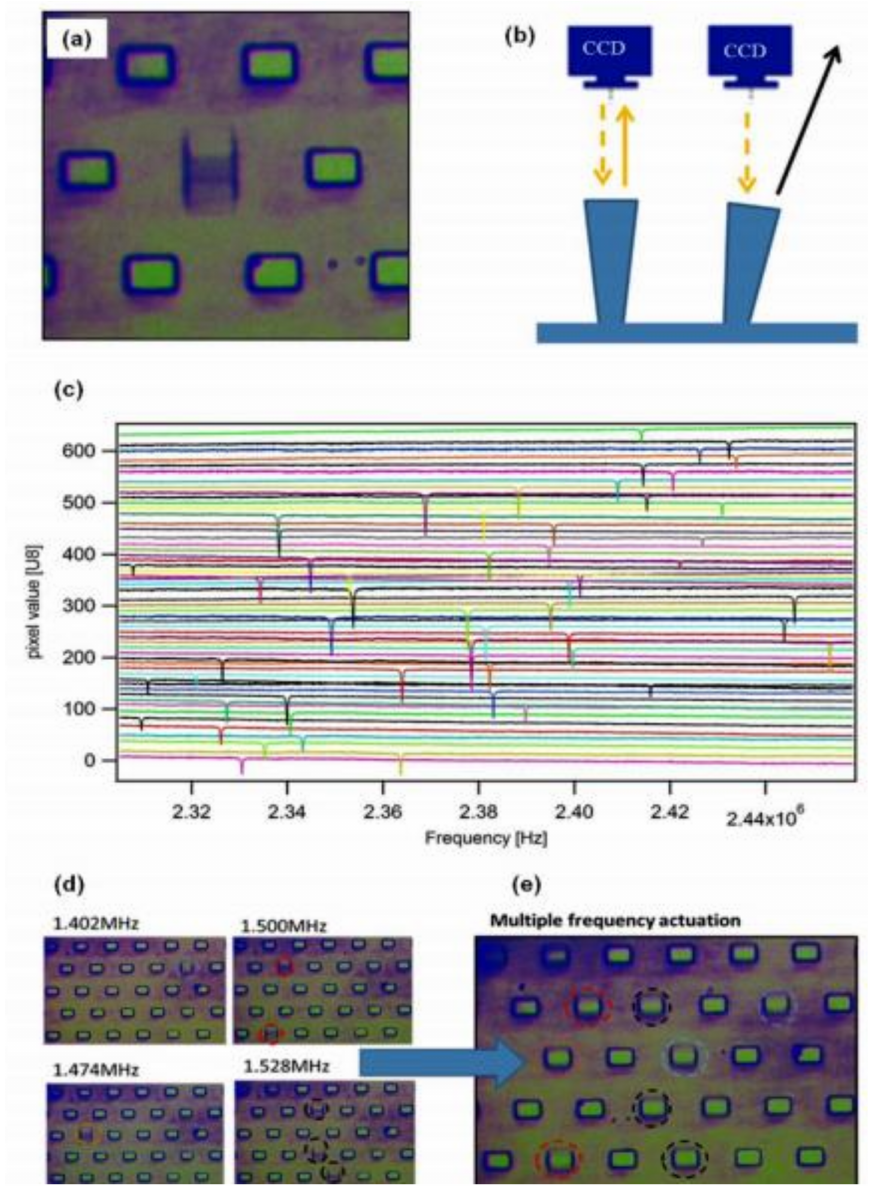
Figure 3. ( a ) T-shaped pillar array and its optical image; ( b ) Process of measuring the intensity as a function of frequency; ( c ) 53 traces corresponding to 53 different pillars as a function of actuation fre- quency. Actuation mode, ( d ) single-mode, and ( e ) multiple modes. Reproduced from Reference [29] with permission. Copyright 2015,